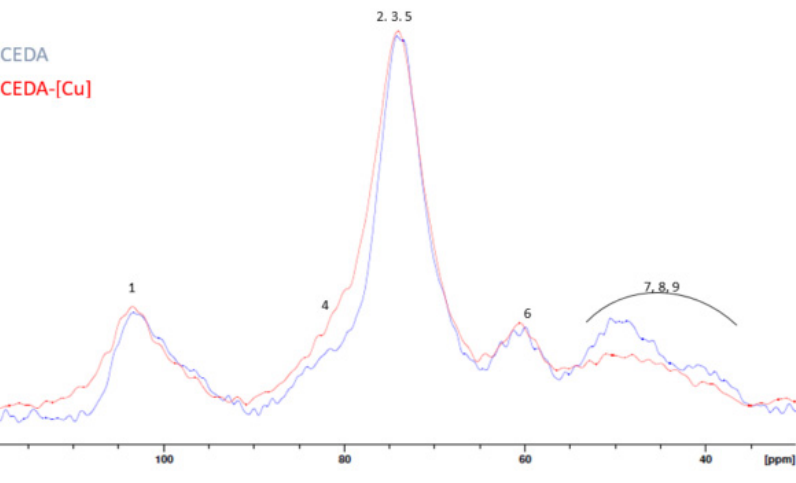
Figure 4. Comparison of CPMAS 13 C-NMR of CEDA and